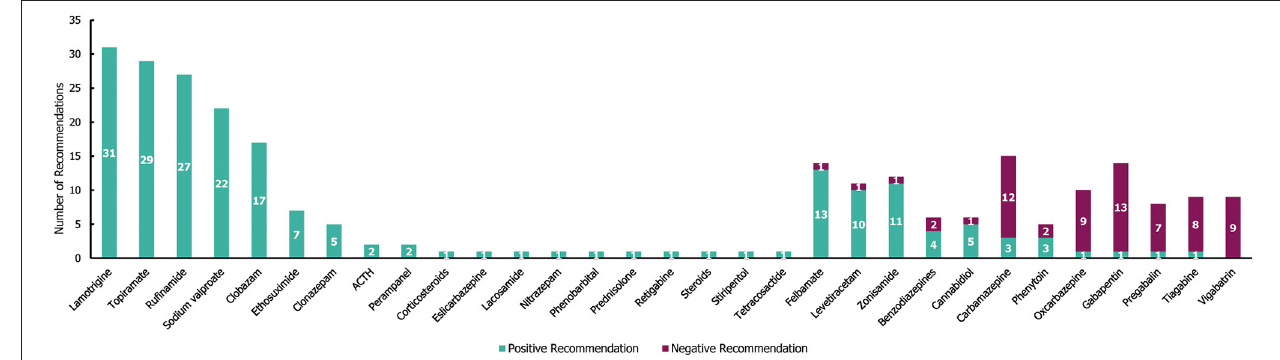
FIGURE 8 | Treatment recommendations for Lennox-Gastaut syndrome. N = 271 (205 positive and 66 negative treatment recommendations) from 34 guidelines. Positive recommendation: use of an individual ASM treatment that was recommended for use in a specific indication, irrespective of the line of treatment (e.g., first line) or whether the treatment was adjunctive; negative recommendation: an individual ASM treatment that was highlighted as a potential option by a guideline but whose use was recommended against (for any reason) in a specific indication, irrespective of the line of treatment, or whether the treatment was adjunctive.